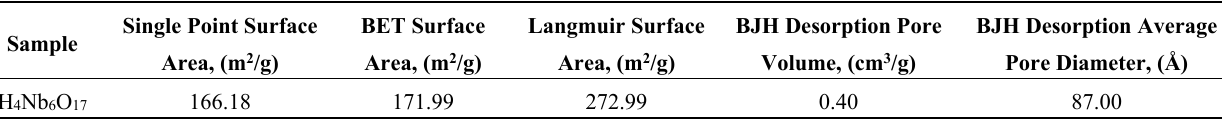
Table 1. BET surface area measurement for nanotube porous oxide